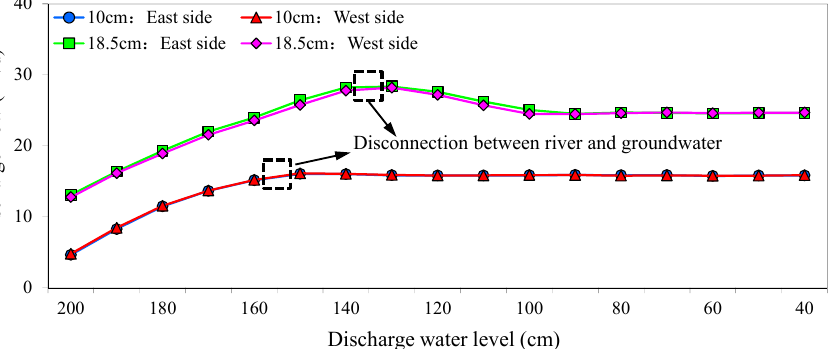
Figure 5. The relationship between discharge flow and discharge water level and river water depth under the water-bearing medium sand C.